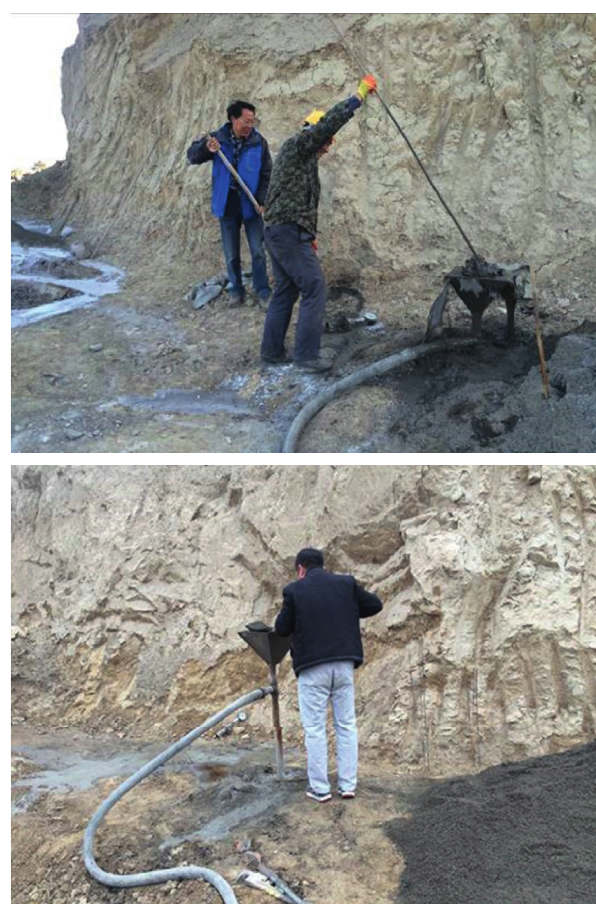
Figure 19: Test of throwing sand into hole.